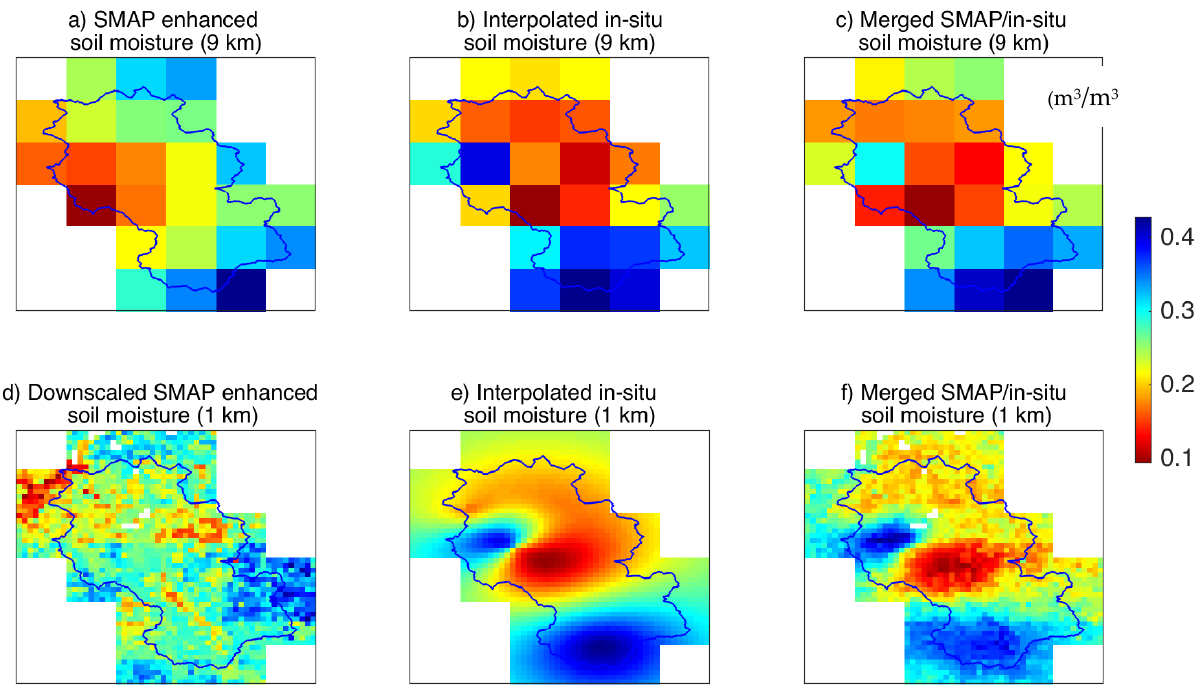
Figure 4. Maps of the spatial distribution of: ( a ) SMAP-enhanced soil moisture; ( b ) interpolated in-situ soil moisture at 9 km; ( c ) merged SMAP/in-situ at 9 km; ( d ) downscaled SMAP-enhanced at 1 km; ( e ) interpolated in-situ at 1 km; ( f ) merged SMAP/in-situ soil moisture at 1 km.